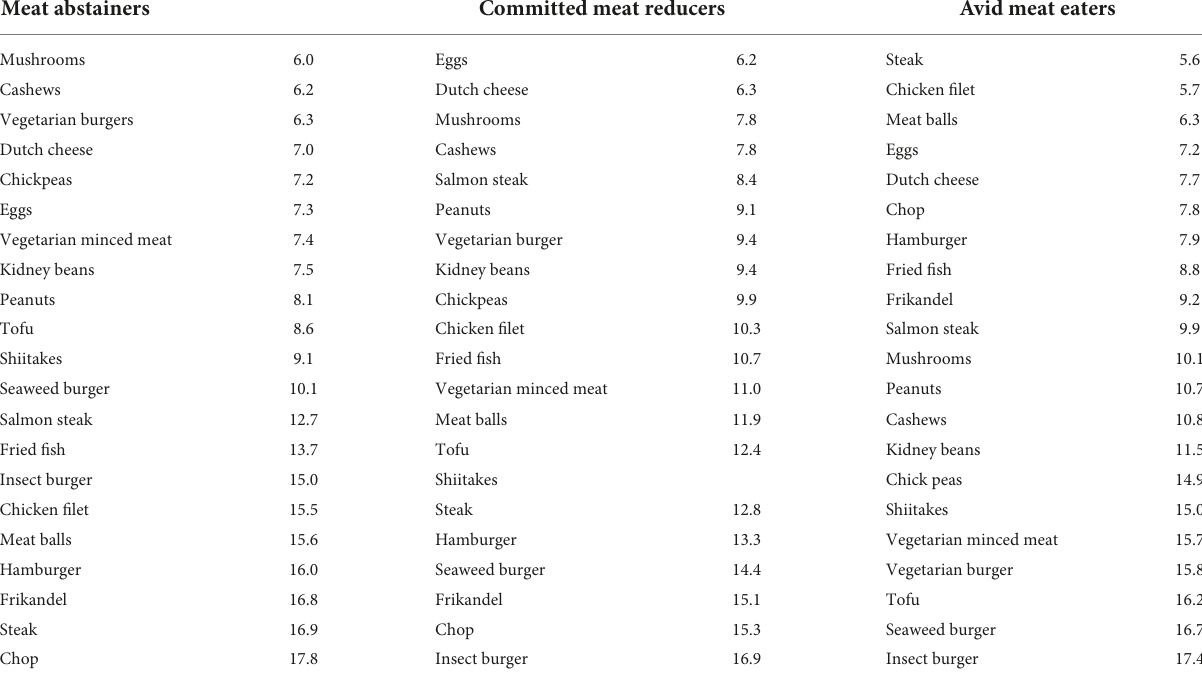
TABLE 3 Ranking of meat products and meat alternatives from most liked to least liked per dietary consumer group. Meat abstainers Committed meat reducers Avid meat eaters